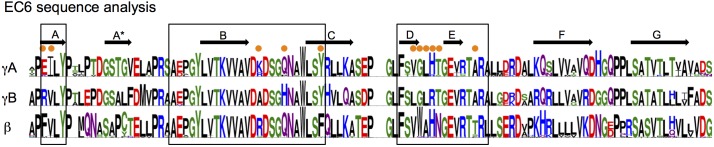
EC6 sequence analysis.Sequence logos generated from alignments of all mouse alternate γA, γB, and β-Pcdhs. Secondary structure elements from the γB2 EC6 structure are annotated above. The face of EC6 that is predicted to mediate cis interactions from mutagenesis experiments and computational methods (Figure 6) is boxed. Residues in these regions that show conserved differences between γA, γB, and β-Pcdhs are marked with orange dots.